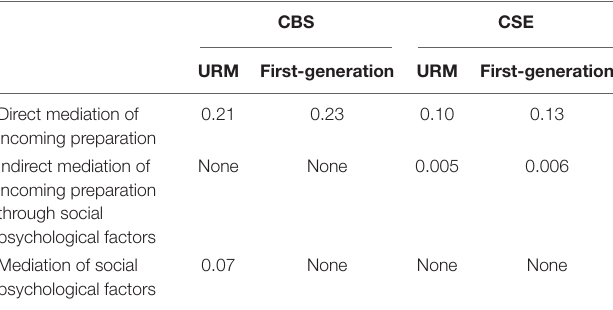
TABLE 7 | The size of different mediation paths for URM and first-generation (Fgen) in total grade across the College of Biological Sciences (CBS) and the College of Science & Engineering (CSE) in standard deviation